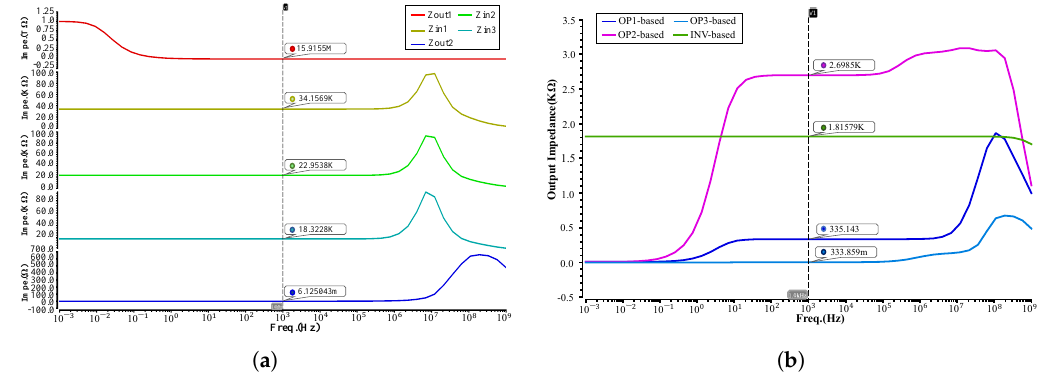
Figure 10. Impedance issue of cascading. ( a ) Comparison between the output impedance and the input impedance. ( b ) The output impedance of the circuit after inserting